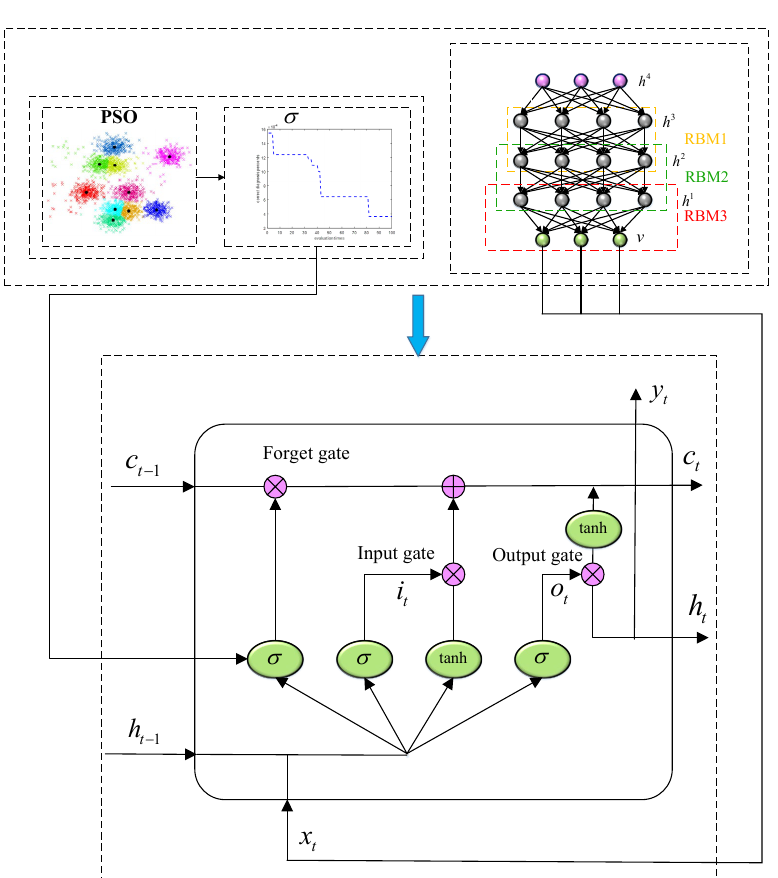
Figure 8. PSO−DBN−LSTME algorithm. Figure 8. PSO − DBN − LSTME